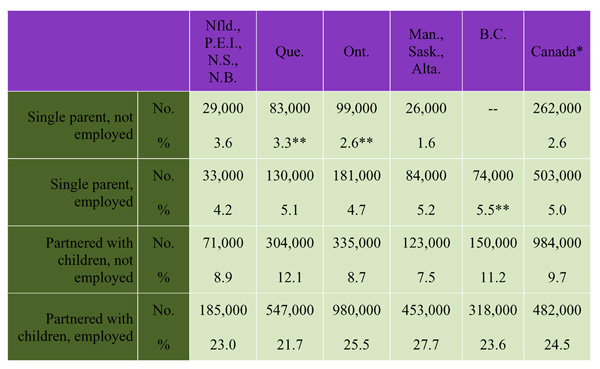
Social Role Profiles of Mothers, Canada and the Provinces, 1998–1999--  Unable to report data (number surveyed is less than 30)  *  The denominator includes all women in Canada between the ages of 15 and 64.  ** Coefficient of variation is high (16.6% to 33.3%)